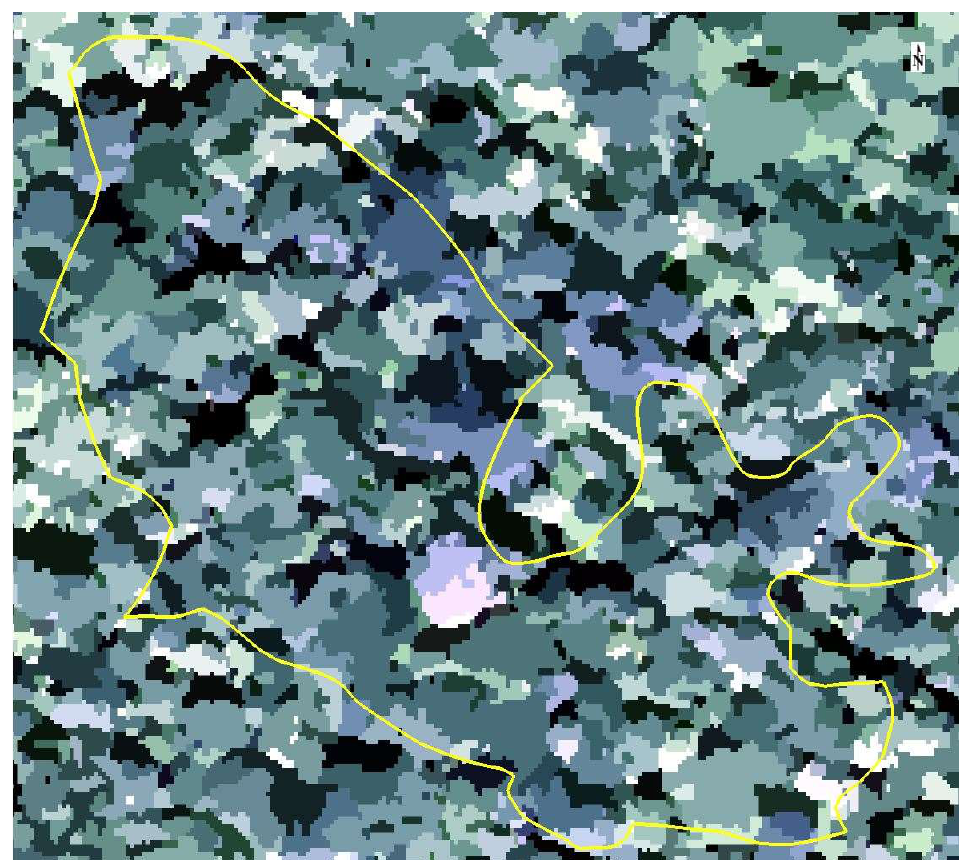
Figure 7. The result of the ENVI segmentation process for the Arboretum based on a setting of 11 for scale and 86 for merge in the segmentation settings. Each defined colorized segmented feature represents an object in the image with like qualities and reflective properties. The values of the two SVIs defined the segments (Table 4), maximizing the differentiation in the imagery between